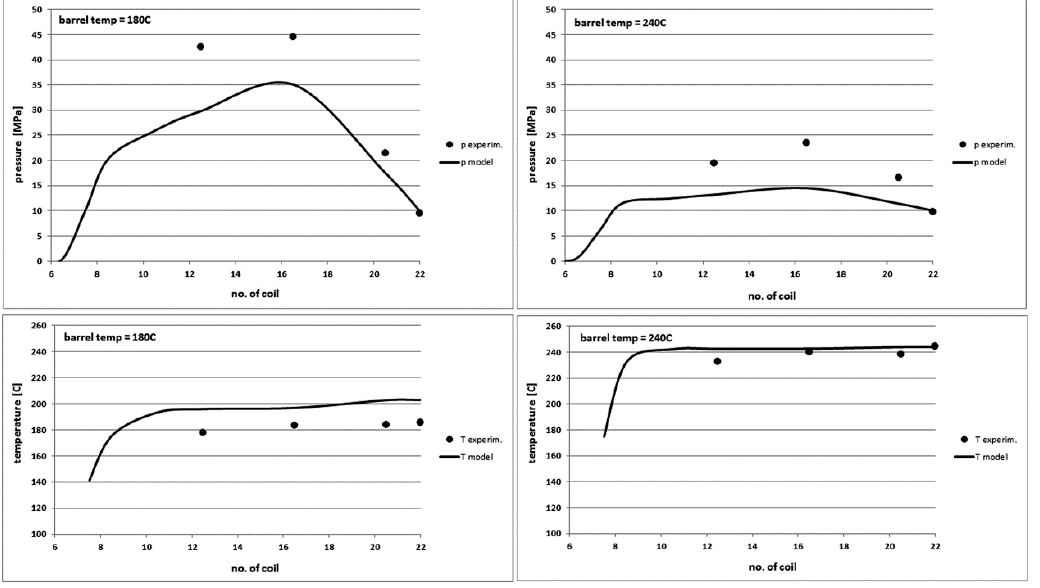
Figure 14. Comparison of theoretical and experimental characteristics of pressure ( top ) and temperature profiles ( bottom ) on the screw channel length in PS injection process for the mean barrel temperature of 180 ° C ( left ) and 240 ° C ( right ).